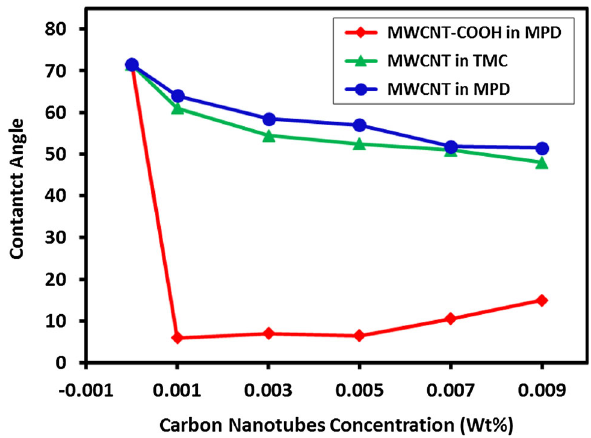
Fig. 9 Contact angle of modified membranes with MWCNT Fig. 10 Permeate flux and salt rejection of pristine-MWCNT in MPD